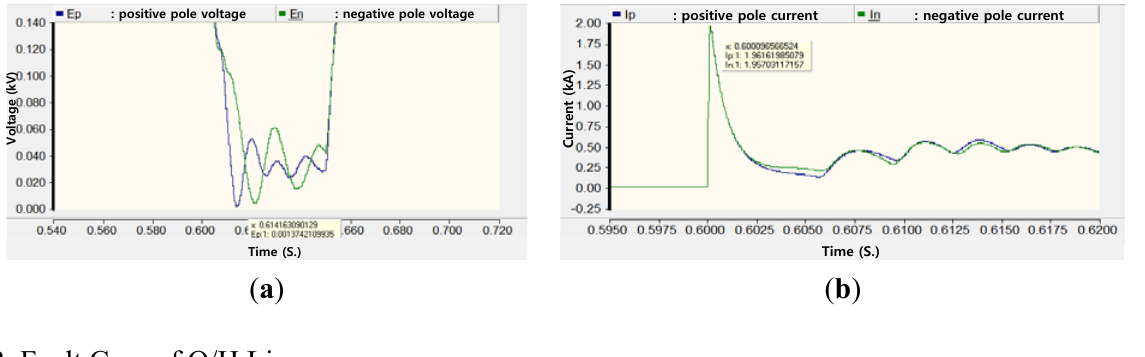
Figure 7. Enlarged resulting waveforms of U/G cable: ( a ) voltage and ( b ) current.